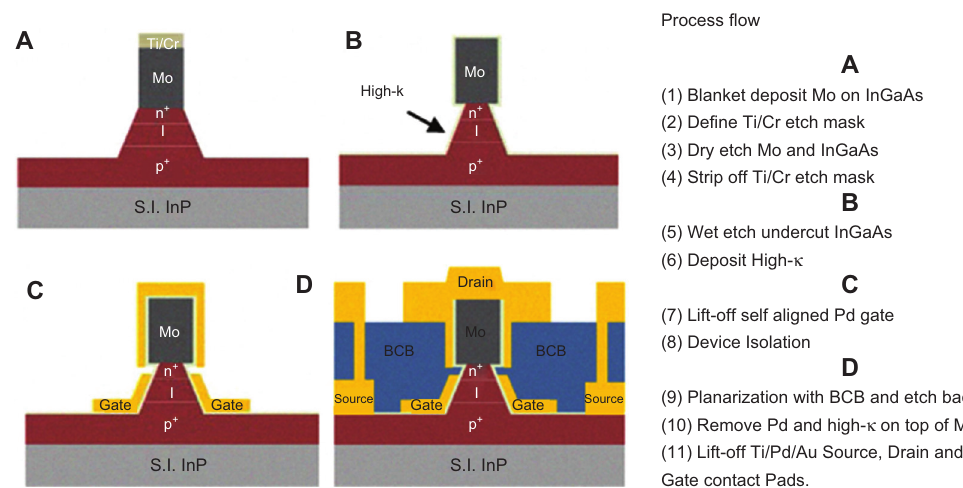
Figure 23 Cross-section schematics of the TFET device followed by key process steps. The fabrication process flow is shown on the right. Reprinted from Ref. [56], with permission, from